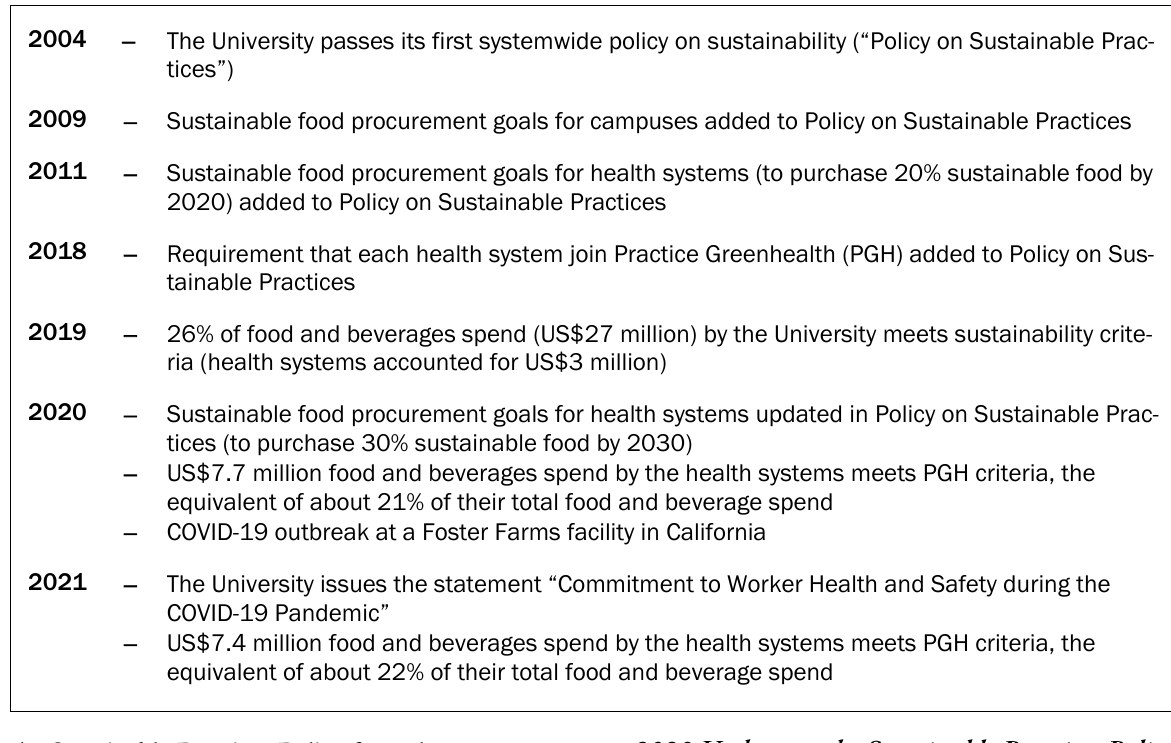
Figure 1. Summary of Sustainable Food Procurement Policy Goals and Milestones at the University